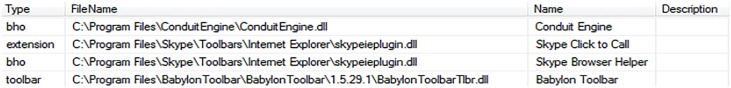
User addons record: Sample user 1.